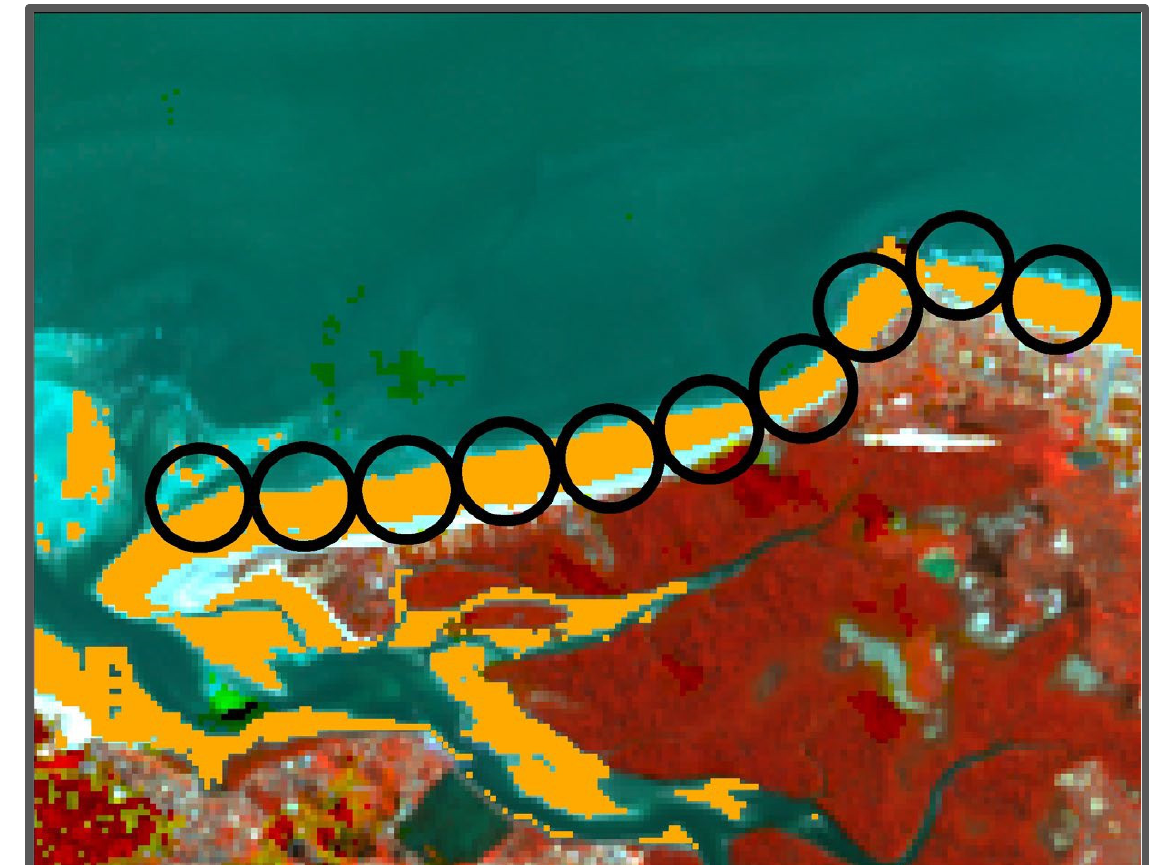
Figure 2. Surveys consisted of 250 m radius (500 m diameter) areas (depicted as black circles) conducted along transects across beach and mud flats accessed either by boat or foot. To ensure that environmental variables sampled for plot characteristics only represented the intertidal zone, a mask (orange) was utilized to limit plot statistics to the intertidal zone. Table 1. Common name, four-letter alpha code, and Latin name of the eight modeled migratory shorebird species. Listed for each species is the number of presence points used in model calibration, validation, and in total, as well as the number of reserved absence points used in validation.